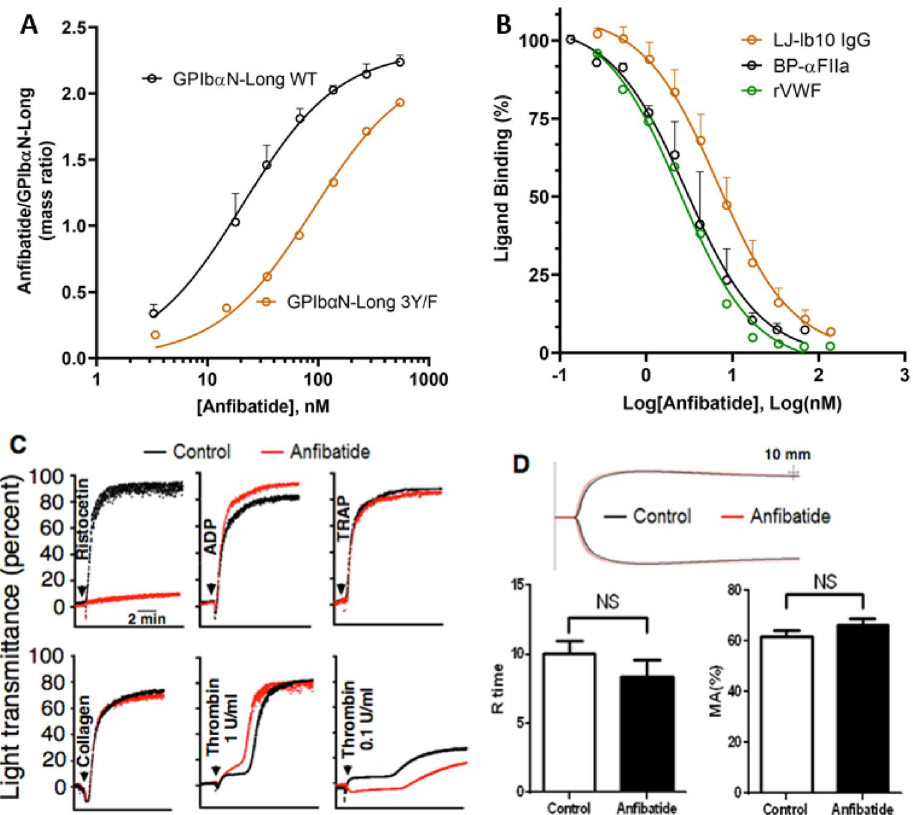
Figure 2. Anfibatide binding to GPIbα prevented VWF and thrombin binding as well as platelet aggregation induced by ristocetin/VWF and low-dose thrombin, but had no effect on blood clotting. ( A ) SPR analysis of anfibatide binding to disulfide-linked dimeric GPIbαN-Long (a chimera of human GPIbα residues − 2 to 288 with 133 residues of SV40 large T antigen) either with wild-type (WT) GPIbα sequence or with Tyr to Phe substitution of residues 276, 278 and 279 (3Y/F). GPIbαN-Long was captured onto the SPR chip by an immobilized anti-SV40-T mAb, followed by anfibatide at increasing concentrations. Data are presented as the ratio of anfibatide/GPIbαN-Long mass bound to the SPR chip during the equilibrium phase (prior to dissociation) and are fit to a one-site ligand binding model. Mass ratio ± SD, N = 3, Black: GPIbαN-Long WT; Orange: GPIbαN-Long 3Y/F. ( B ) Inhibition of α-thrombin (BP-αFIIa), VWF A1 domain or mAb LJ-Ib10 binding to GPIbα on human washed platelets by increasing anfibatide concentrations. Data are presented as % binding, relative to the binding of the ligand at a concentration equal to the K D of the ligand in the absence of anfibatide. The data was fit to the Cheng–Prusoff transformation 79 . Ligand binding % ± SD, N = 3, Black: BP-αFIIa; Orange: LJ-Ib10; Green: rVWF. ( C ) Platelet aggregation was induced by ristocetin (1.2 mg/mL) (P < 0.001), ADP (20 μM) (P > 0.05), TRAP (500 μM) (P > 0.05), or collagen (10 µg/mL) (P > 0.05) in anfibatide- treated (6 µg/mL) PRP or by thrombin (0.1–1 U/mL) in gel-filtered platelets. Curves are from representative light transmission aggregometry plots. ( D ) Clot formation was measured by thromboelastography in anfibatide- treated whole blood. Anfibatide (6 µg/mL) did not significantly alter the time to initial clot formation (R time, min ± SEM) or maximum clot strength (MA ± SEM). NS, no significant difference. Red: anfibatide-treated plasma. Black: untreated plasma (N =